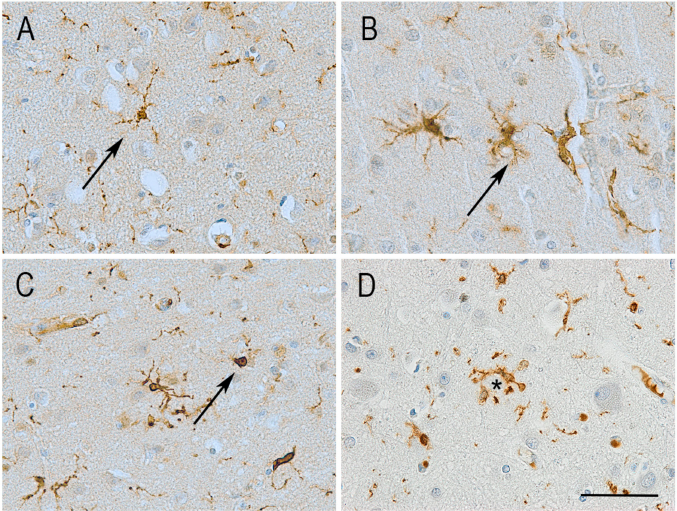
Figure 1. Illustration of the di ff erent morphologies adopted by microglia in the human brain independently of age or disease. Immunolabelling for the microglial protein Iba1 shows diverse morphologies including varying number of processes and cell body shape. ( A ) Ramified microglia with small round cell body and several long branching processes. ( B ) Reactive microglia with increased cell body size and reduced length of processes. ( C ) Amoeboid microglia with enlarged cell body and no processes. Images A–C taken from a control aged brain. ( D ) Microglia clustering around A β plaques (*) is a feature observed only in the presence of Alzheimer-type pathology. Haematoxylin counterstaining. Scale bar = 50 µ